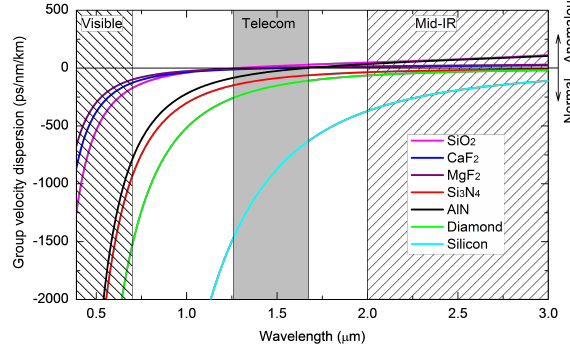
Figure 2: Group velocity dispersion ( D parameter) of different ma- terials that have been employed for Kerr comb generation. Plotted with the data from Ref.